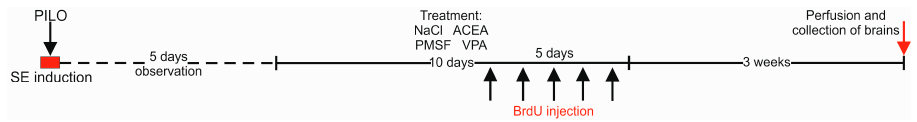
Figure 5. Schematic illustration of the experimental design used in the study. Experimental procedure: PILO—pilocarpine injection; SE—status epilepticus; ACEA—arachidonyl-2 ′ -chloroethylamide; PMSF—phenylmethylsulfonyl fluoride; VPA—valproic acid;